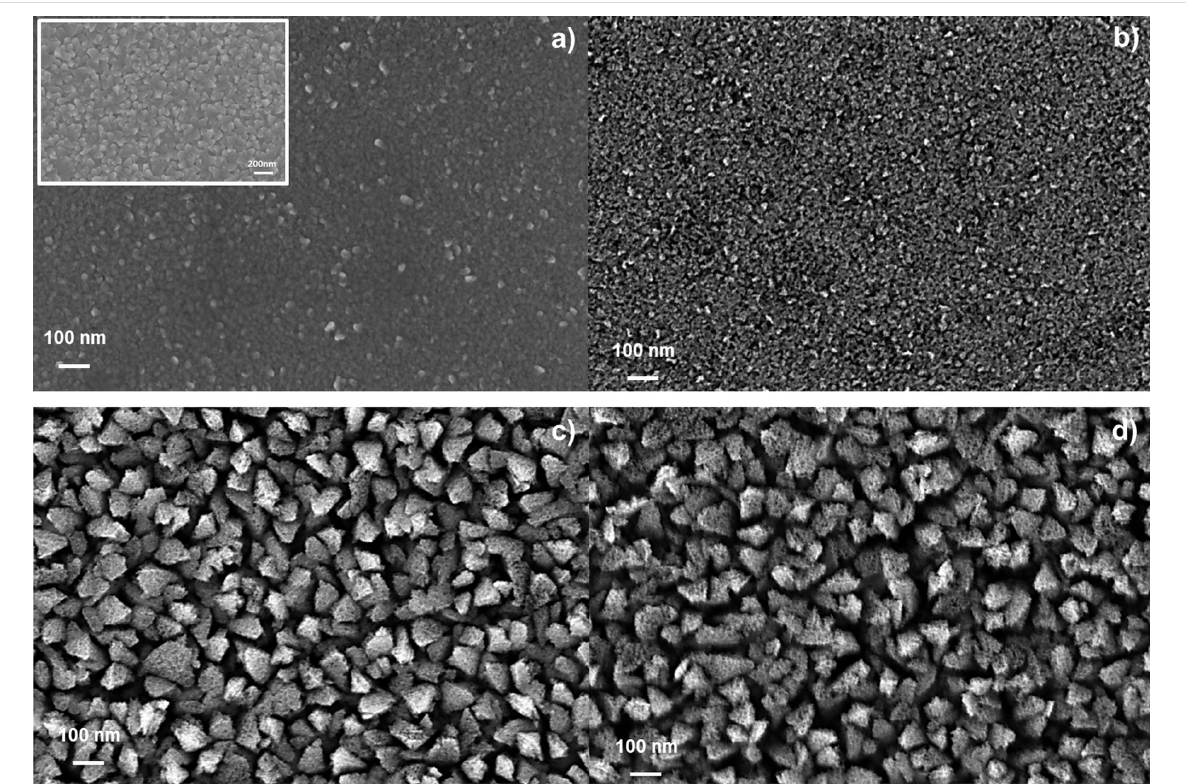
Figure 1: SEM images of a Ti film (70 nm thick) after etching for (a) 60 and (b) 150 s. Images of a Ti film (430 nm thick) after etching for (c) 150 and (d) 190 s. Inset of panel (a): Ti film before the